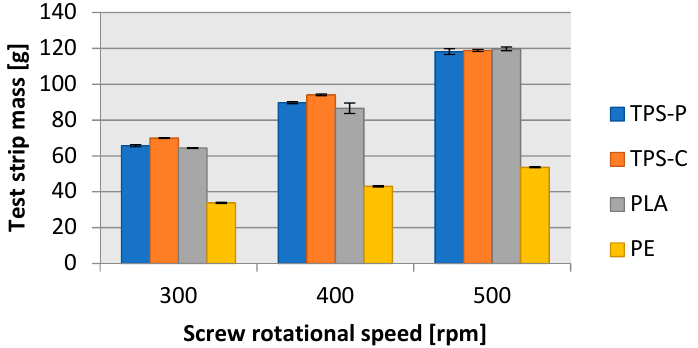
Figure 14. Dependence of the test strip mass of film collection on the rotational speed of the extruder screw.